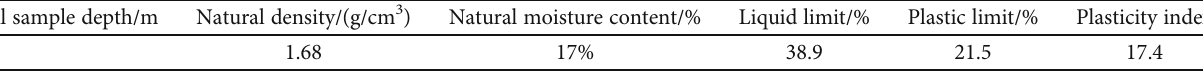
Table 1: The initial physical property indexes of the undisturbed soil sample.